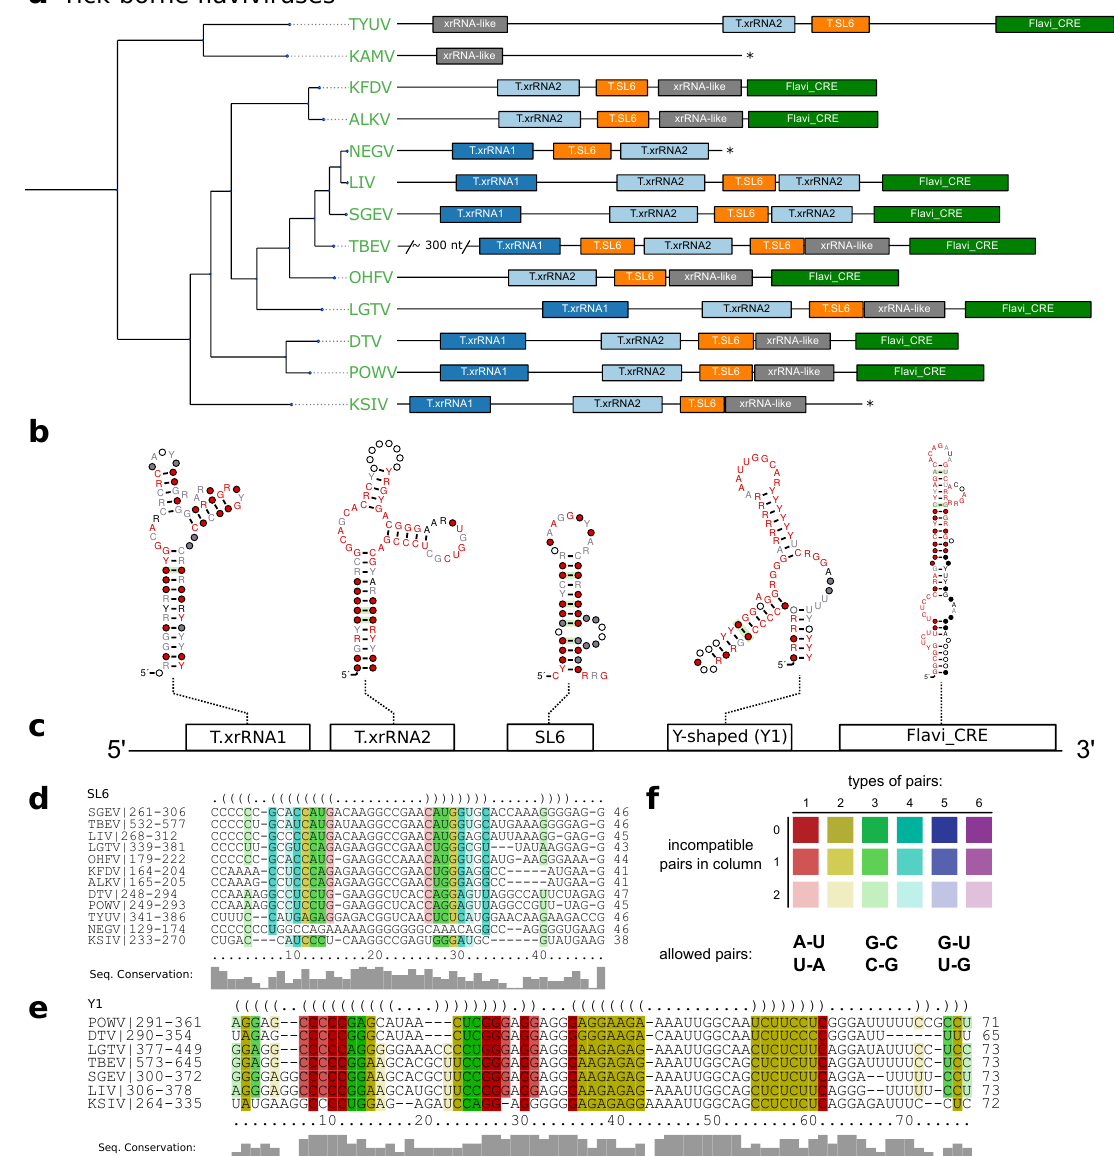
Figure 3. ( a ) Annotated 3 (cid:48) UTRs of TBFVs. The phylogenetic tree on the left has been computed from complete coding sequence nucleotide alignments and corresponds to the TBFV subtree in Figure 1. For each species with available 3 (cid:48) UTR sequence a sketch of the 3 (cid:48) UTR is drawn to scale next to the leaves of the tree. Colored boxes represent conserved RNA structural elements. Identifiers within the boxes indicate the CM which was used to infer homology at this position. Asterisks indicate incomplete 3 (cid:48) UTR sequences. Species without available 3 (cid:48) UTR are not shown. ( b ) Consensus structure plots of CM hits as calculated by mlocarna . ( c ) Schematic depiction of the common structural architecture of TBFV 3 (cid:48) UTRs. ( d , e ) Structural alignments of elements SL6 and Y1. ( f ) RNAalifold coloring scheme for paired columns in alignments. Colors indicate the number of basepair combinations found in pair of columns. Fainter colors indicate that some sequences cannot form a base